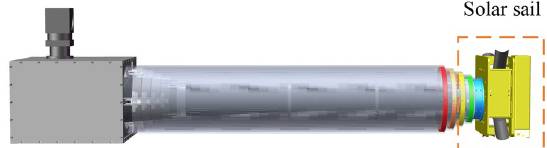
Figure 4 Solar sail load at tip of TTM